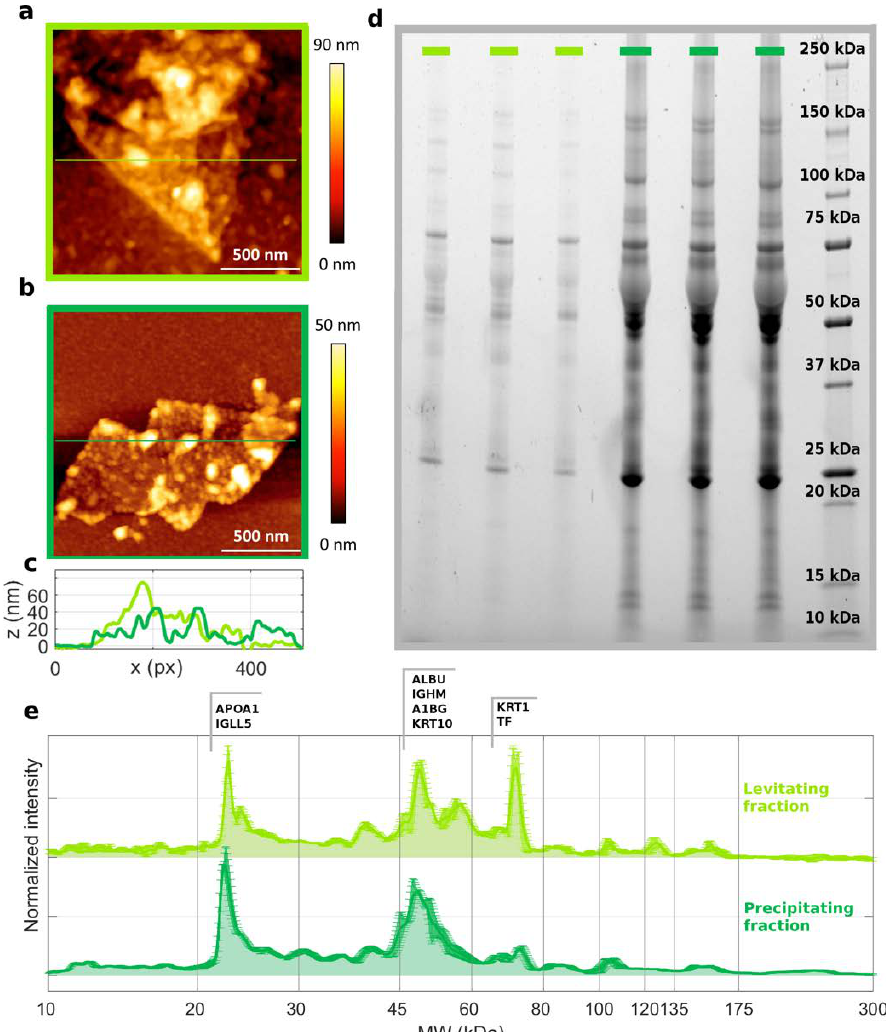
Figure 4. Atomic force microscopy (AFM) images for ( a ) levitating and ( b ) precipitating fractions of GO-HP samples collected after the MagLev measurements. ( c ) Z-profiles of the levitating (light green) and precipitating fractions (dark green). ( d ) Representative 1D SDS-PAGE image of the investigated samples (measurements were performed in triplicates) and ( e ) corresponding intensity profiles, which were normalized to the total lane intensity. The dominant protein contributions for the main peaks are reported in Table S2, as detected in nanoliquid chromatography–tandem mass spectrometry experiments.